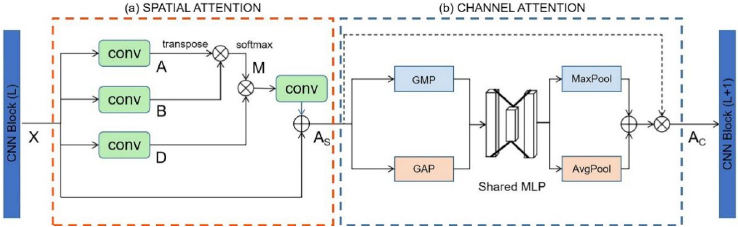
Figure 3. Non-local attention module (NLAM) inserted between the L th and L + 1 th blocks of CNN. NLAM mainly includes two parts: ( a ) NLAM spatial attention; ( b ) NLAM channel attention. X represents the feature maps output by the L th CNN block; A S expresses the feature maps after NLAM spatial attention; A C indicates the feature maps after NLAM channel attention as the input of the L + 1 th block. ‘ ⊕ ’ denotes the addition operation based on elementwise. ‘ ⊕ ’ denotes matrix multiplication. The green box represents 1 × 1 convolution. GMP = Global Maximum Pooling, GAP = Global Average Pooling, MLP = Multi-Layer